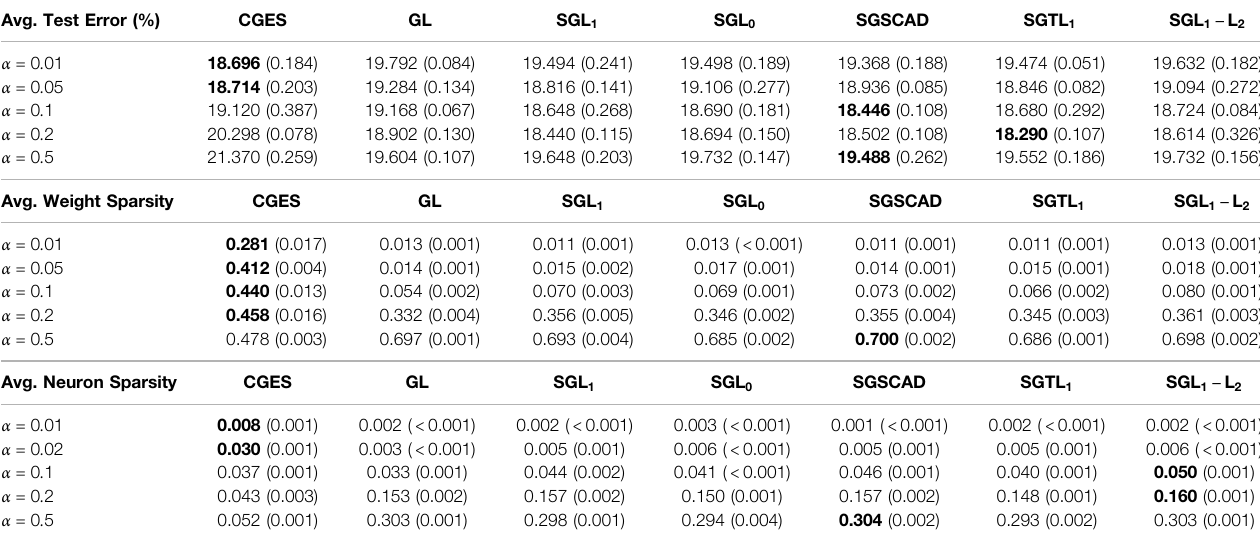
TABLE 9 | Average test error, weight sparsity, and neuron sparsity of WRN-28-10 models trained on CIFAR 100 with lowest test errors across 5 runs. Standard deviations are in parentheses. Avg. Test Error